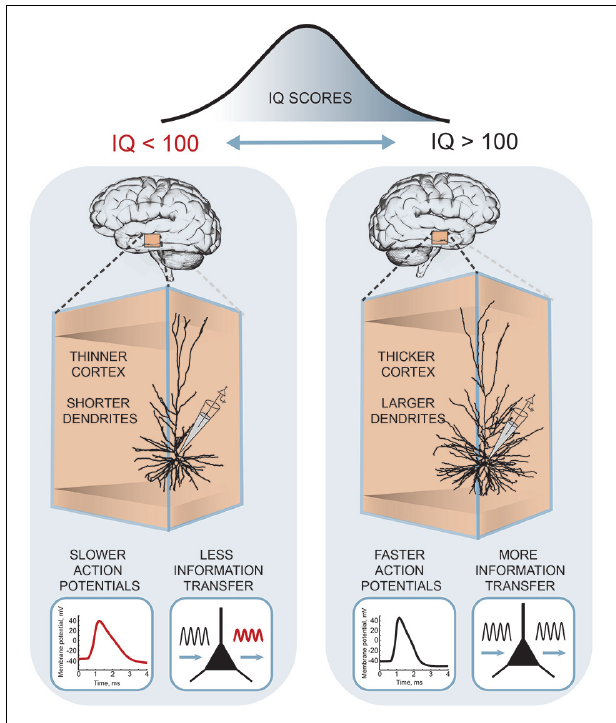
FIGURE 3 | A cellular basis of human intelligence. Higher IQ scores associate with larger dendrites, faster action potentials during neuronal activity and more efficient information tracking in pyramidal neurons of temporal cortex. The figure is based on the results from Goriounova et al.